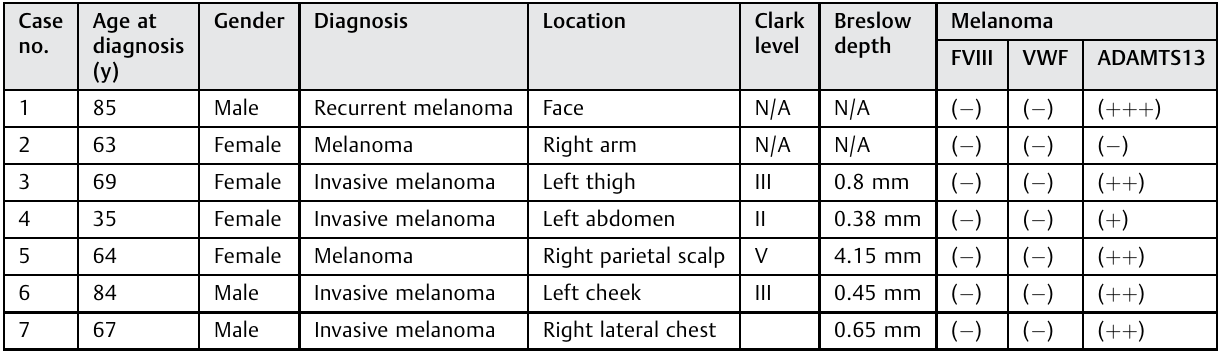
Table 2 Expression of VWF, FVIII, and ADAMTS13 in melanoma tissues by immunohistochemistry Case